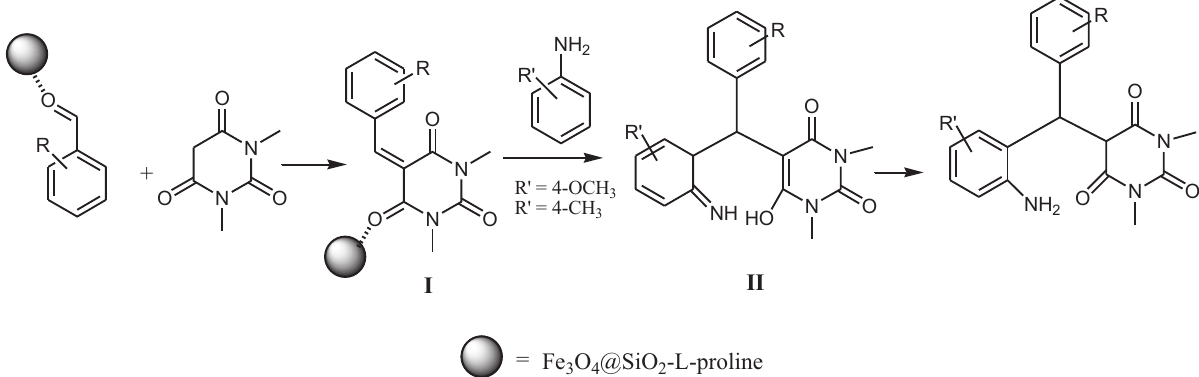
before being dried in an oven at 60°C to give Fe